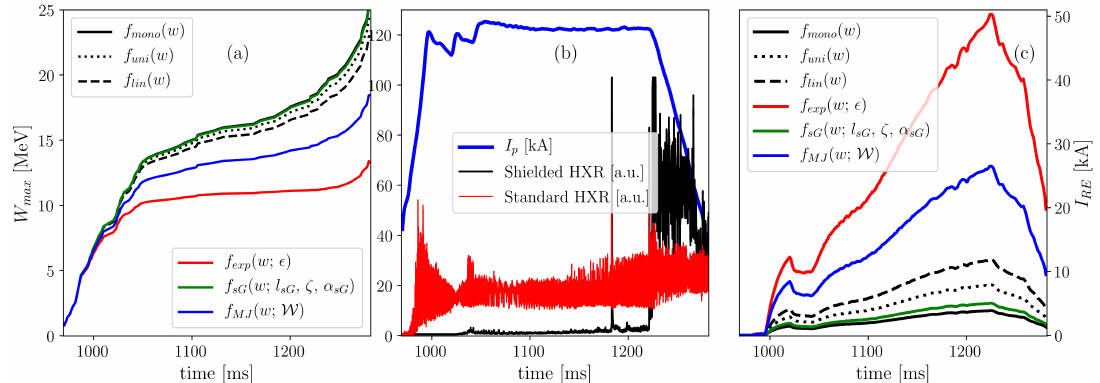
Figure 2. ( a ) The maximum kinetic energy W max of discharge #7298 obtained for the different RE distribution functions: mono-energetic f mono (black solid), uniform f uni (black dotted), linear f lin (black dashed), exponential f exp (red), skewed Gaussian f sG (green) and Maxwell–Jüttner f MJ (blue). ( b ) Time traces of the plasma current I p (blue), Shielded HXR (black) and Standard HXR (red). ( c ) Estimated RE current I RE corresponding to each RE distribution function with the same labeling as on ( a